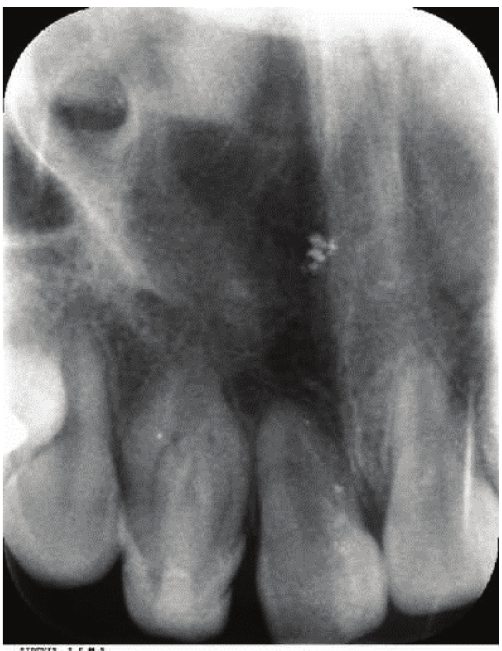
Figure 3: The twenty-month follow-up radiograph showing that the open apex was